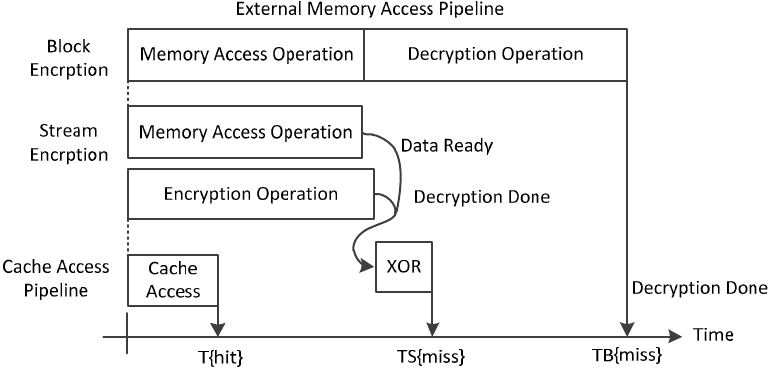
Figure 7. The memory access time diagram of a load operation for the processor.